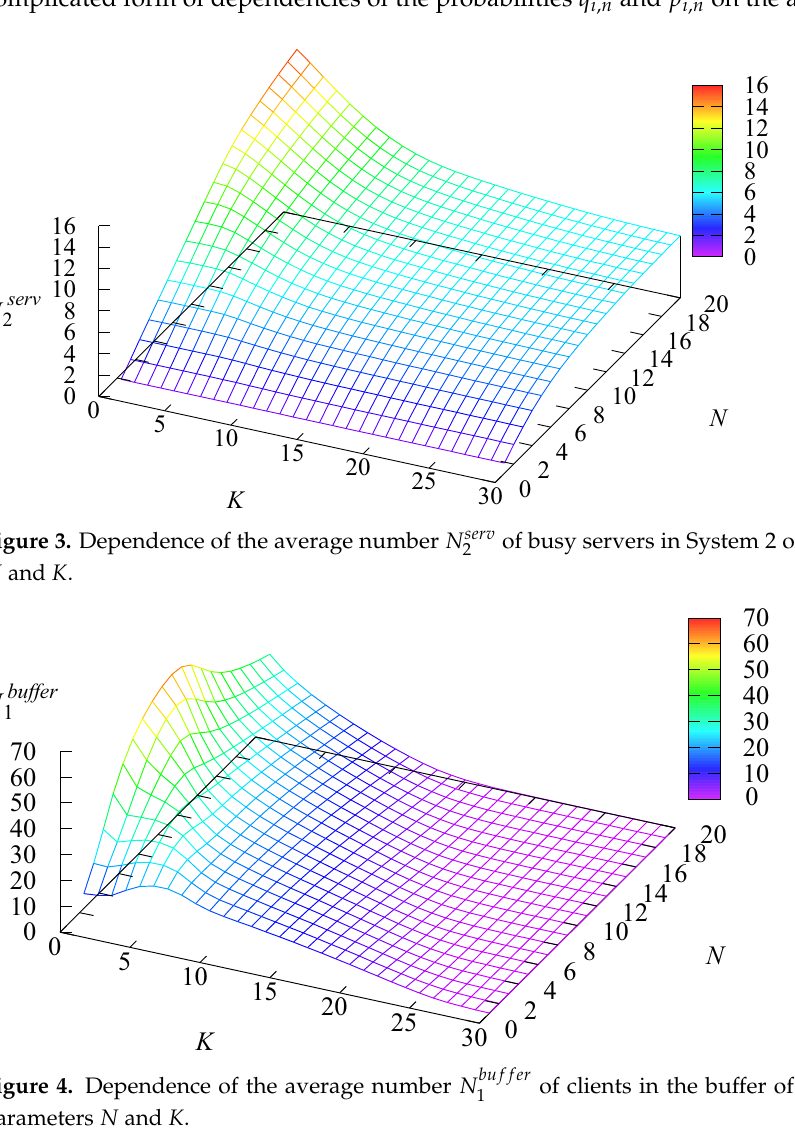
of clients in the buffer of System 1 on the 1